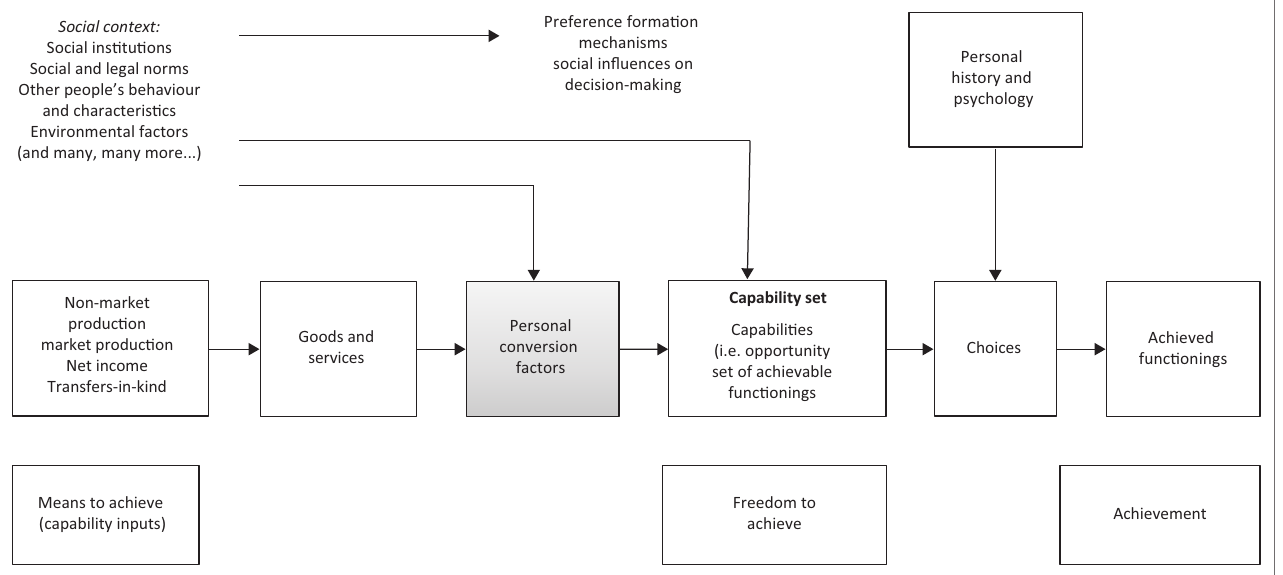
FIGURE 1: Conceptual framework of financial